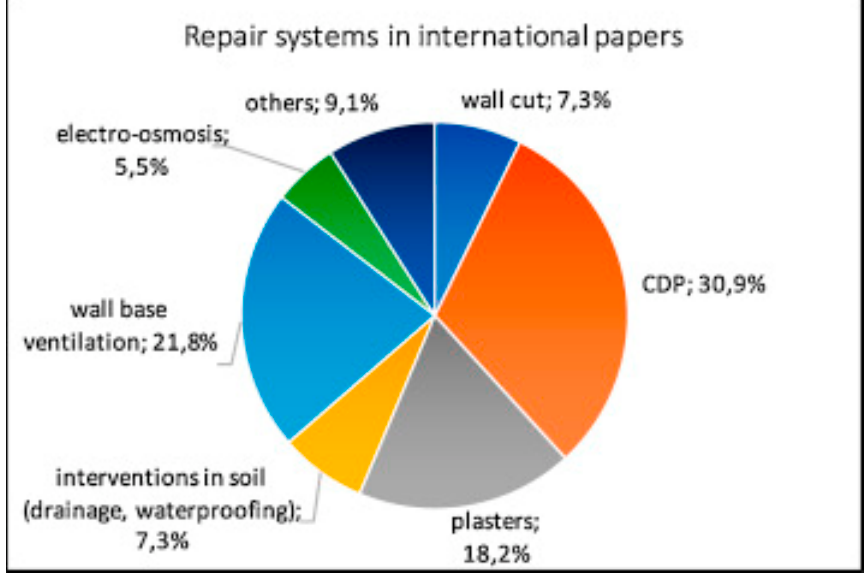
Figure 2. Repair systems considered in the 46 scientific papers examined (papers investigating more than one system were counted more than one time) (CDP: Chemical Damp Proofing) [8].